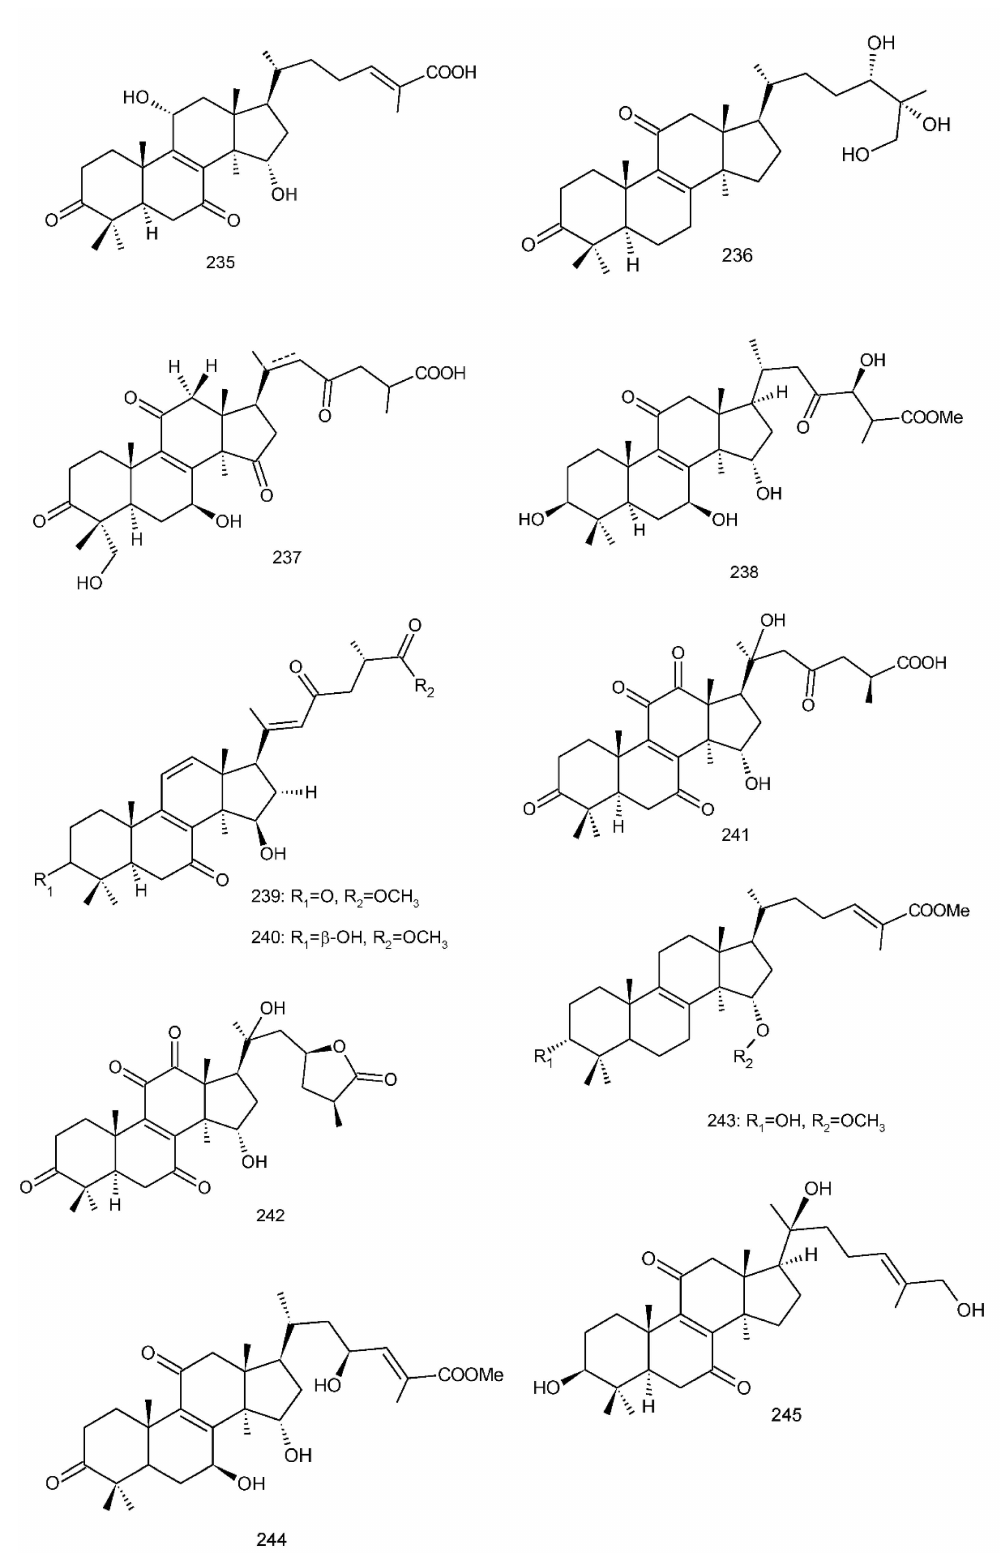
Figure 4. Chemical structures of several 8,9-double-bond triterpenoids